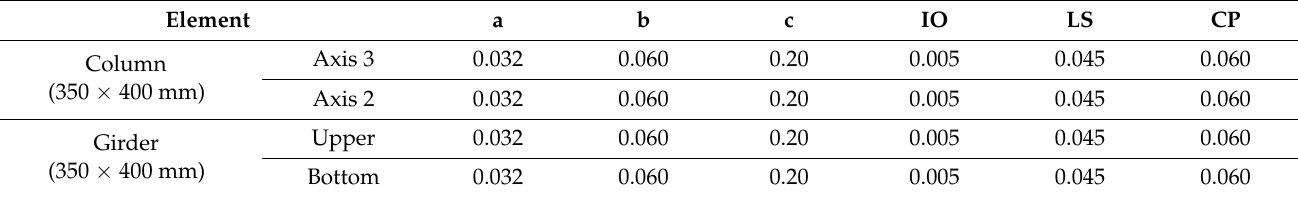
Table 4. Hinge Properties Detail of a Member.